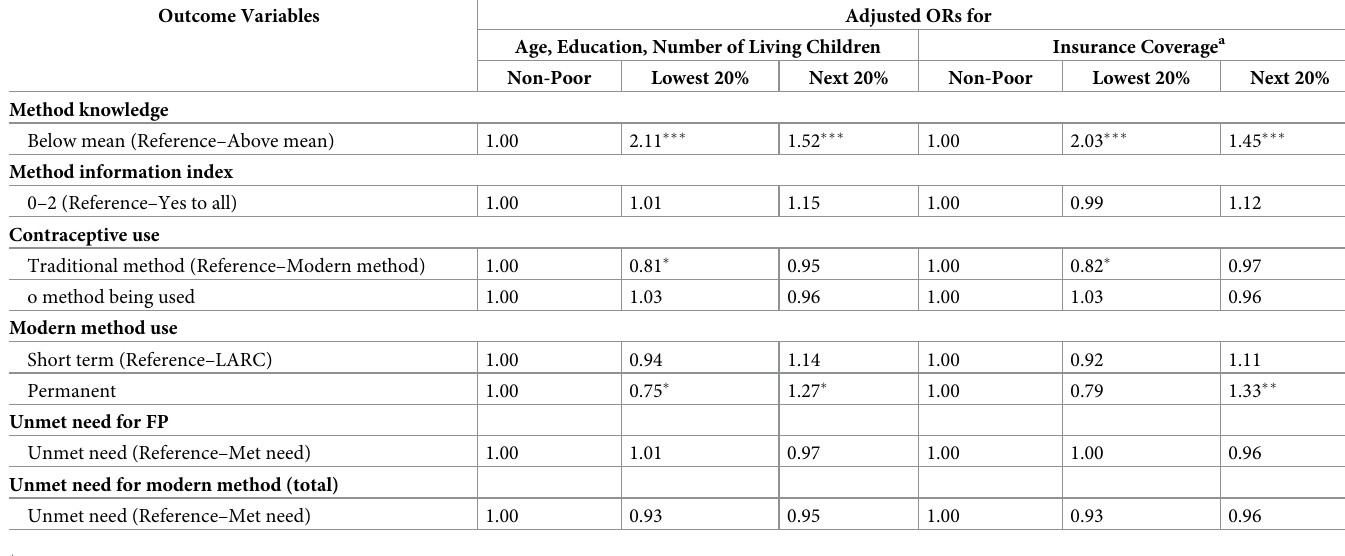
Table 3. Adjusted Odds-Ratios of selected family planning outcomes for urban poor vs. urban non-poor